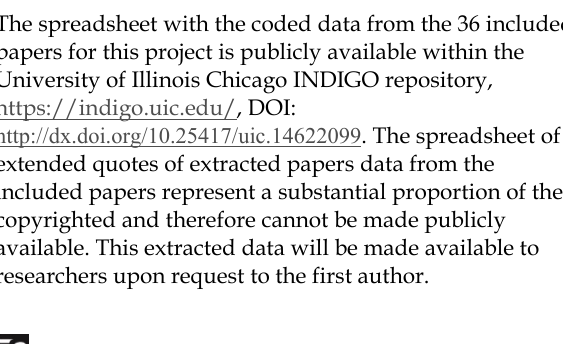
Table 4 Library and organizational-level issues and outcomes represented by themes with